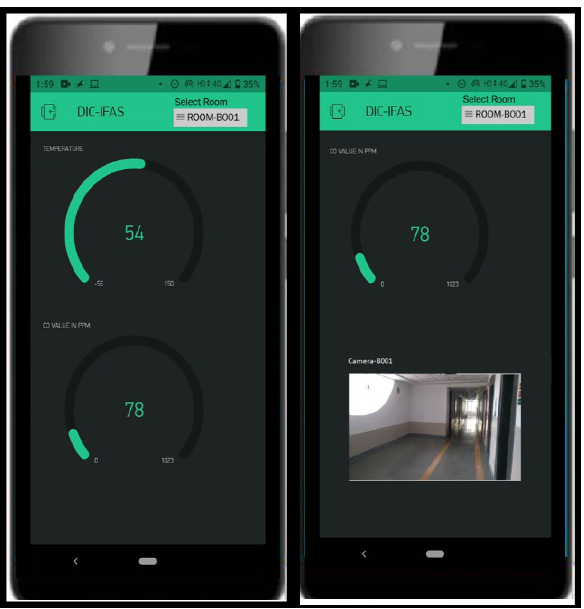
Figure 8. Live information on fire status in mobile with